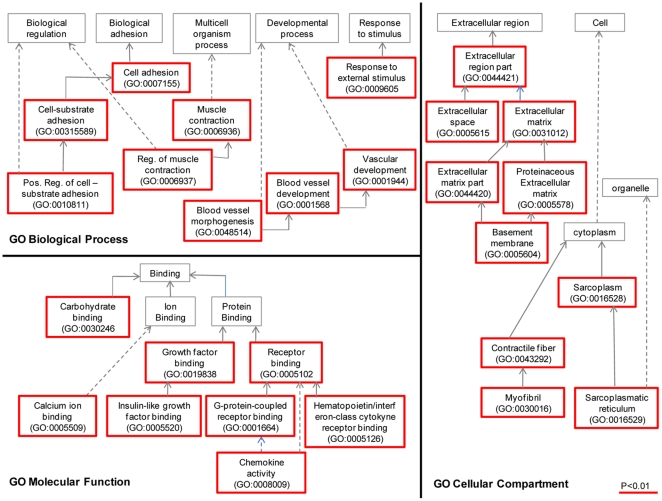
Gene groups enriched in left atrium according to FatiGO gene ontology analysis.220 genes significantly enriched in the left atrium in any of the three microarray datasets (MF1_3; MF1_12; SA_12) were used as input list against the genome. 9 biological process, 10 cellular component, and 8 molecular function enriched GO classes are highlighted in red (levels 3–9; P<0.01).